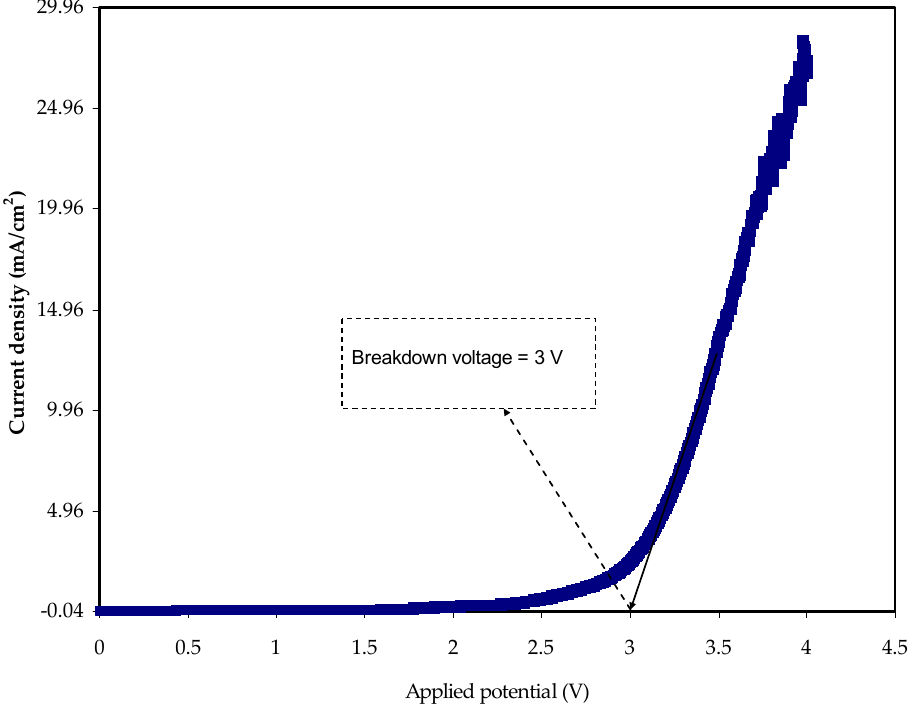
Figure 7. LSV for the MDLG3 film of SPE.